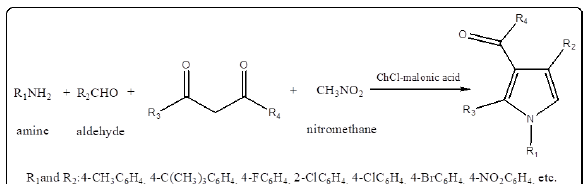
Figure 26: DES catalyzed Paal-Knorr reaction. t